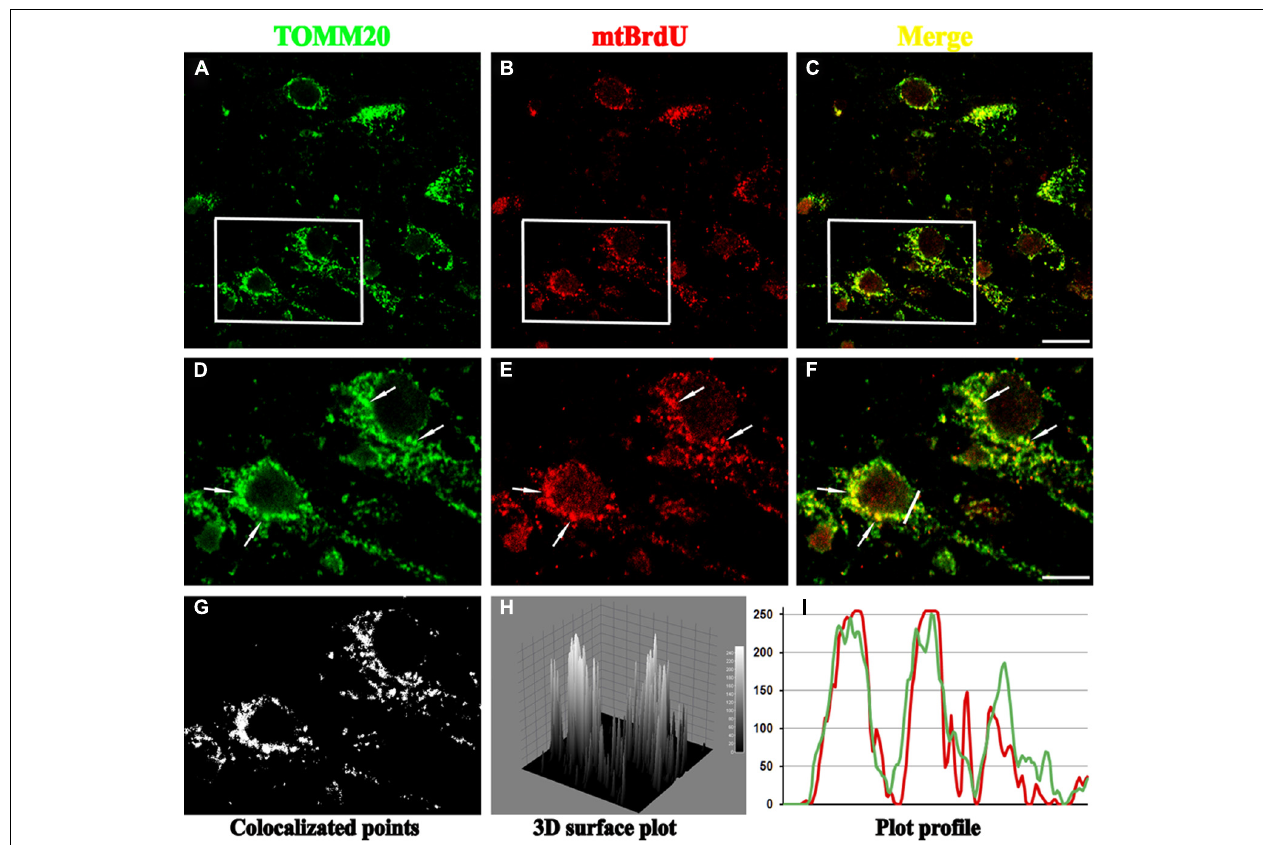
FIGURE 1 | Confocal microscopy of mature hippocampal neuronal culture (15 DIV) double stained forTOMM20 (a mitochondrial marker; green channel) and BrdU (for visualization of newly synthesized mito- chondrial DNA; red channel). BrdU puncta colocalize with severalTOMM20 positive mitochondria (arrows) in cell body, showing that biogenesis of these organelles mainly occurs in perinuclear compartment. (A–C) Lower magnifi-